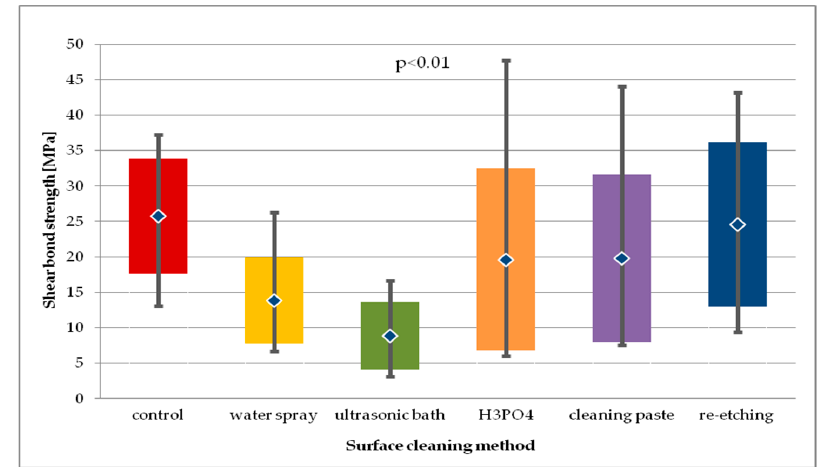
Figure 9. Shear bond strength of resin material to saliva contaminated lithium disilicate glass ceramics (LDGC) using different cleaning methods, after 24-hour water storage. (LDGC) using different cleaning methods, after 24-hour water storage.